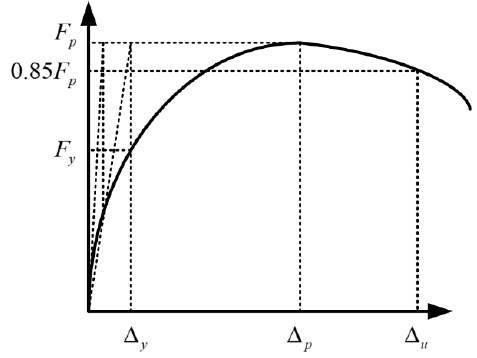
Figure 8. Graphic method to define yield point.